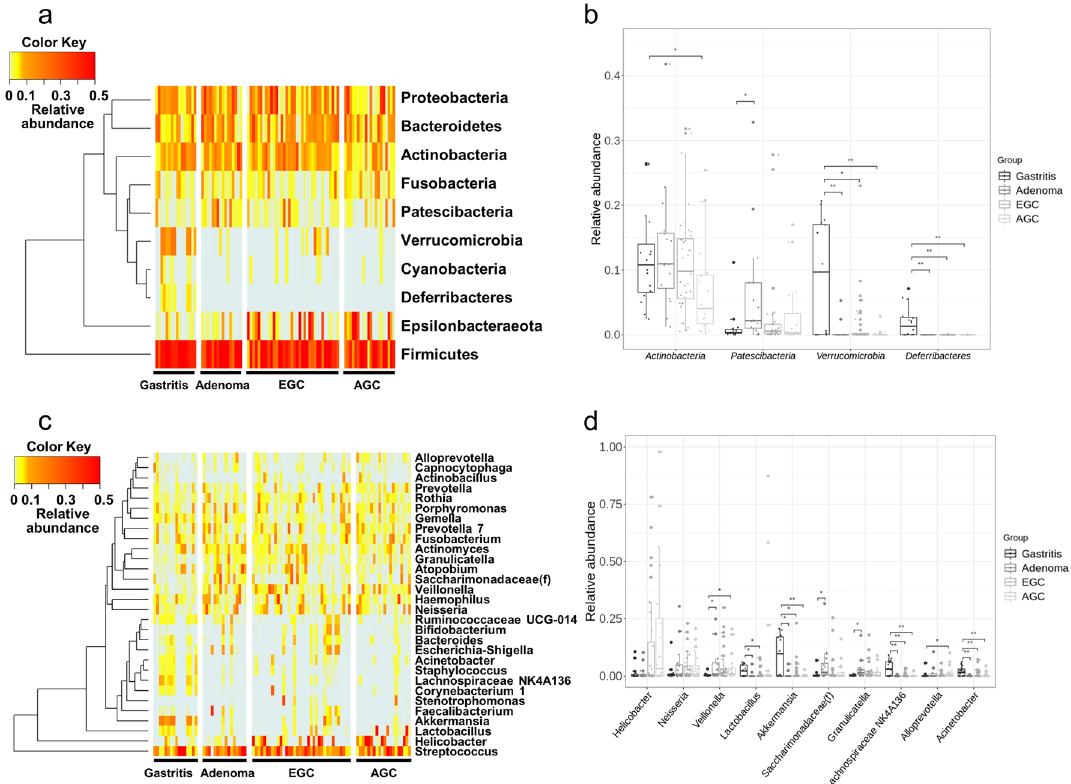
Figure 3. Differences in the relative abundance of gastric microbiome between the disease groups at the phylum and genus level. ( a ) A heatmap demonstrating the relative abundances of gastric microbiome at the phylum level. ( b ) The relative abundances of the bacteria were compared at the phylum level between the four groups (GA, GAD, EGC, and AGC), and those showing clinical significance were demonstrated. ( c ) A heatmap demonstrating the relative abundances of gastric microbiome at the genus level. ( d ) The relative abundances of the bacteria were compared at the genus level between the four groups (GA, GAD, EGC, and AGC), and those showing clinical significance were demonstrated. *q < 0.05, ** < 0.01.